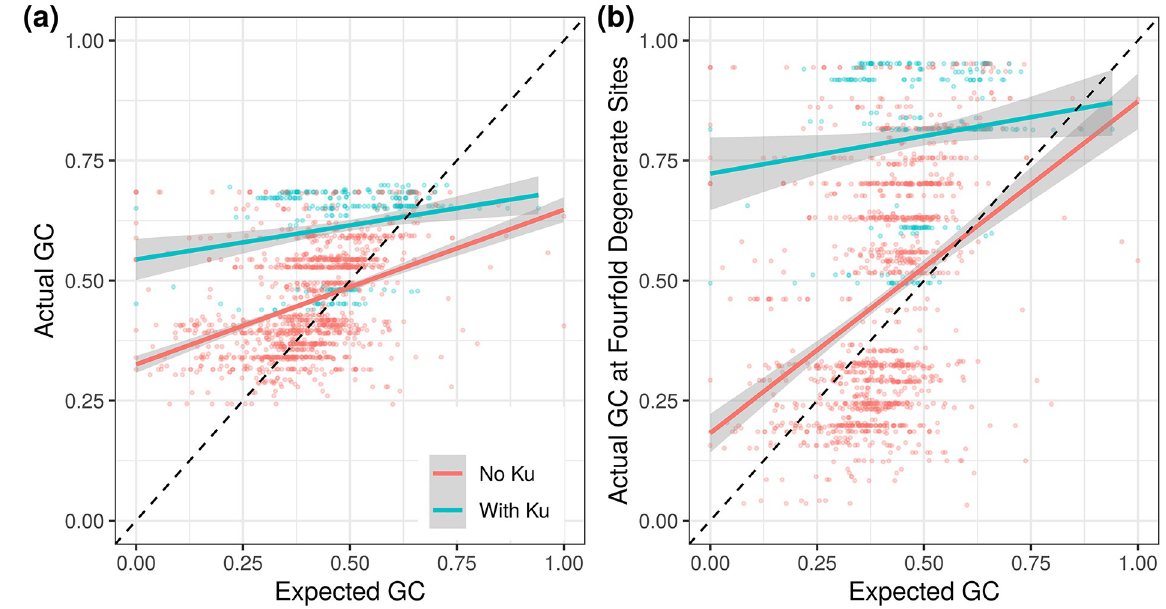
Fig 3. Genomes with Ku appear to fix GC alleles at a greater rate than expected (either due to BGC or selection). (a,b) Genomes with Ku have, on average, even greater elevation of GC content over expectation than genomes without Ku. Expected GC content was estimated from polymorphism data. This signal is conservative due to observed polymorphisms experiencing some effects of BGC/selection (see Methods for discussion).